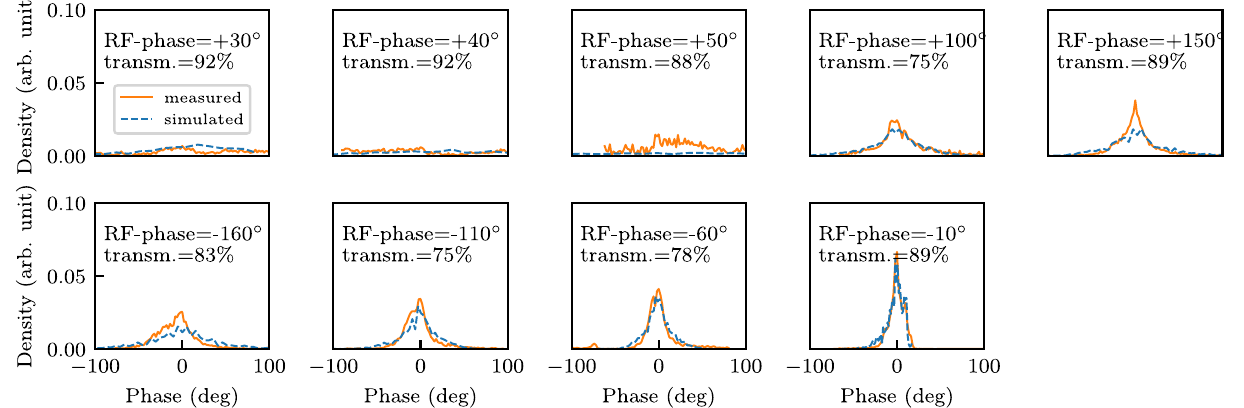
FIG. 8. The phase of the cavity CH0 is varied at fixed rebuncher amplitude. This phase scan is reproduced with DYNAMION simulations using the reconstructed bunch shape as input distribution. The cavity gradient is U 0 ¼ 3 . 3 MV. The maximum acceleration gain is reached for a rf-phase